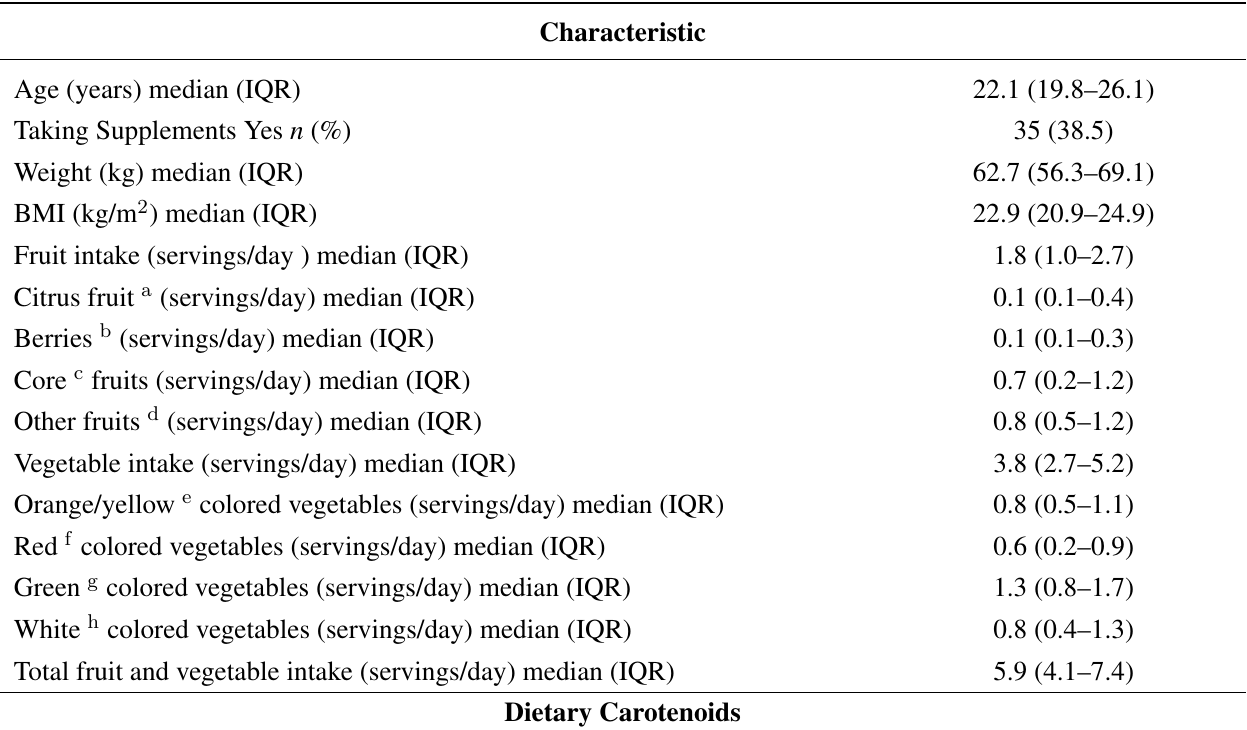
Table 1. Characteristics of women ( n = 91) participating in a cross-sectional evaluation of fruit, vegetable and dietary carotenoid intake and skin color and